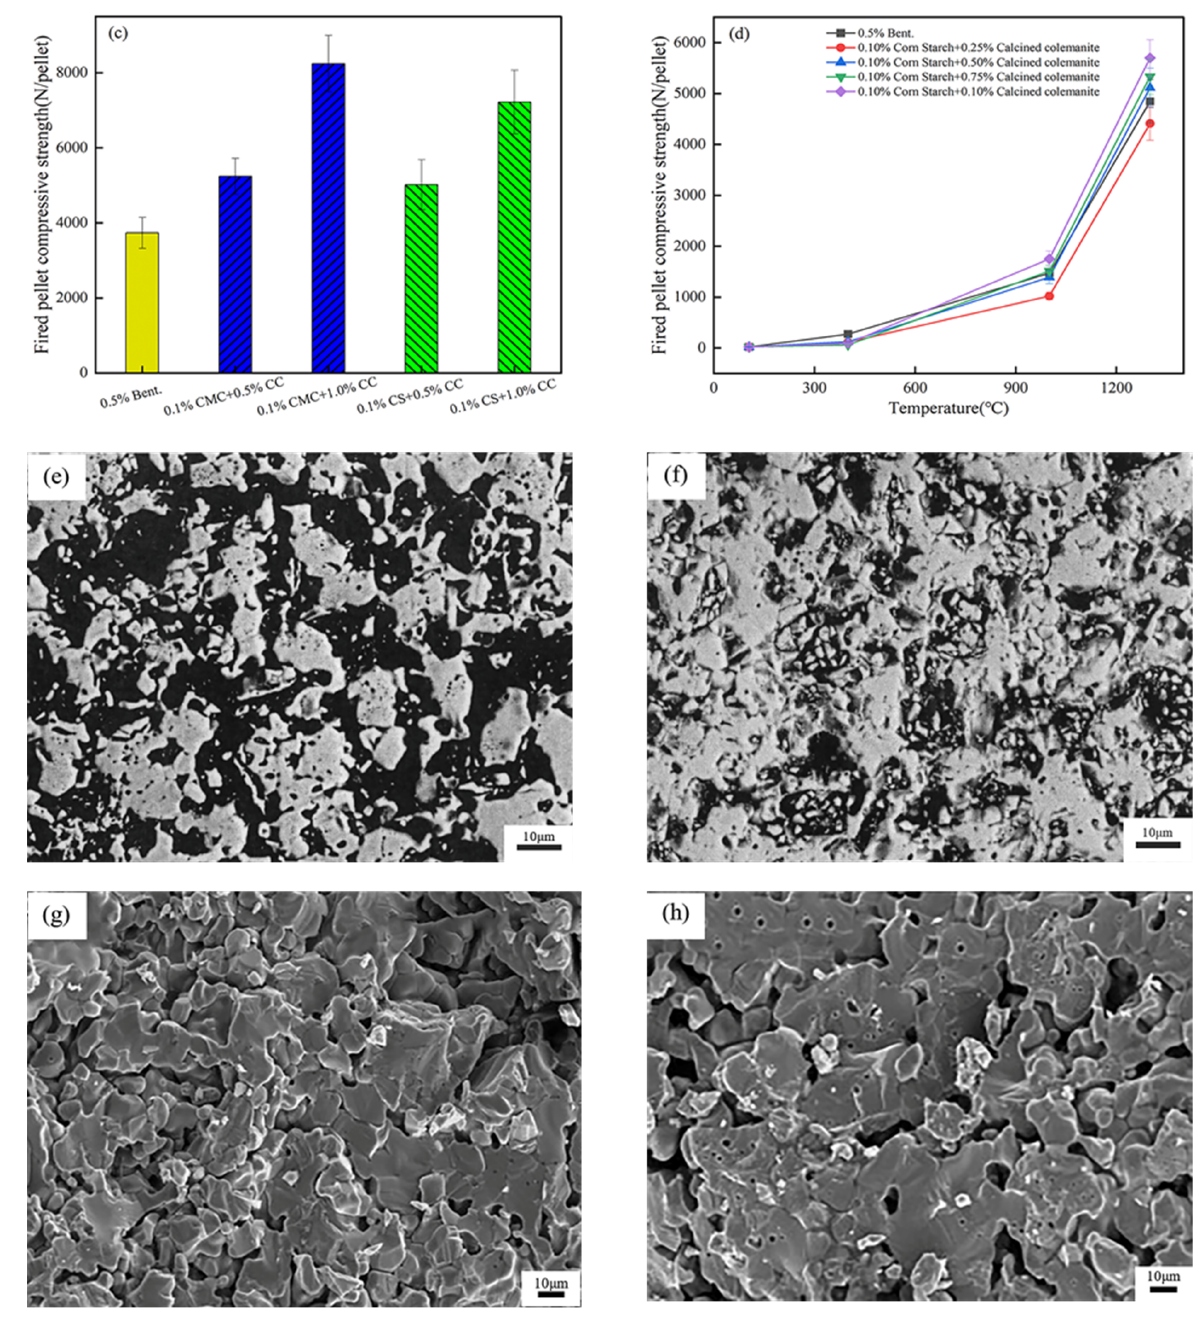
Figure 12. The effect of calcined colemanite or boric acid on the fired pellet compressive strength with ( a – d ) CMC and corn starch [55,122–124]. SEM images of fired pellets with ( e ) no binder. Porosity = 15.31%. ( f ) 0.4% Borax. Porosity = 11.52% [125]. ( g ) 0.50% calcined colemanite. ( h ) 0.10% corn starch + 0.50% calcined colemanite [55].